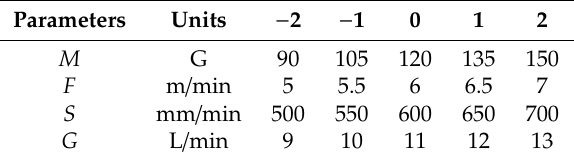
Table 1. Welding parameters and their levels and